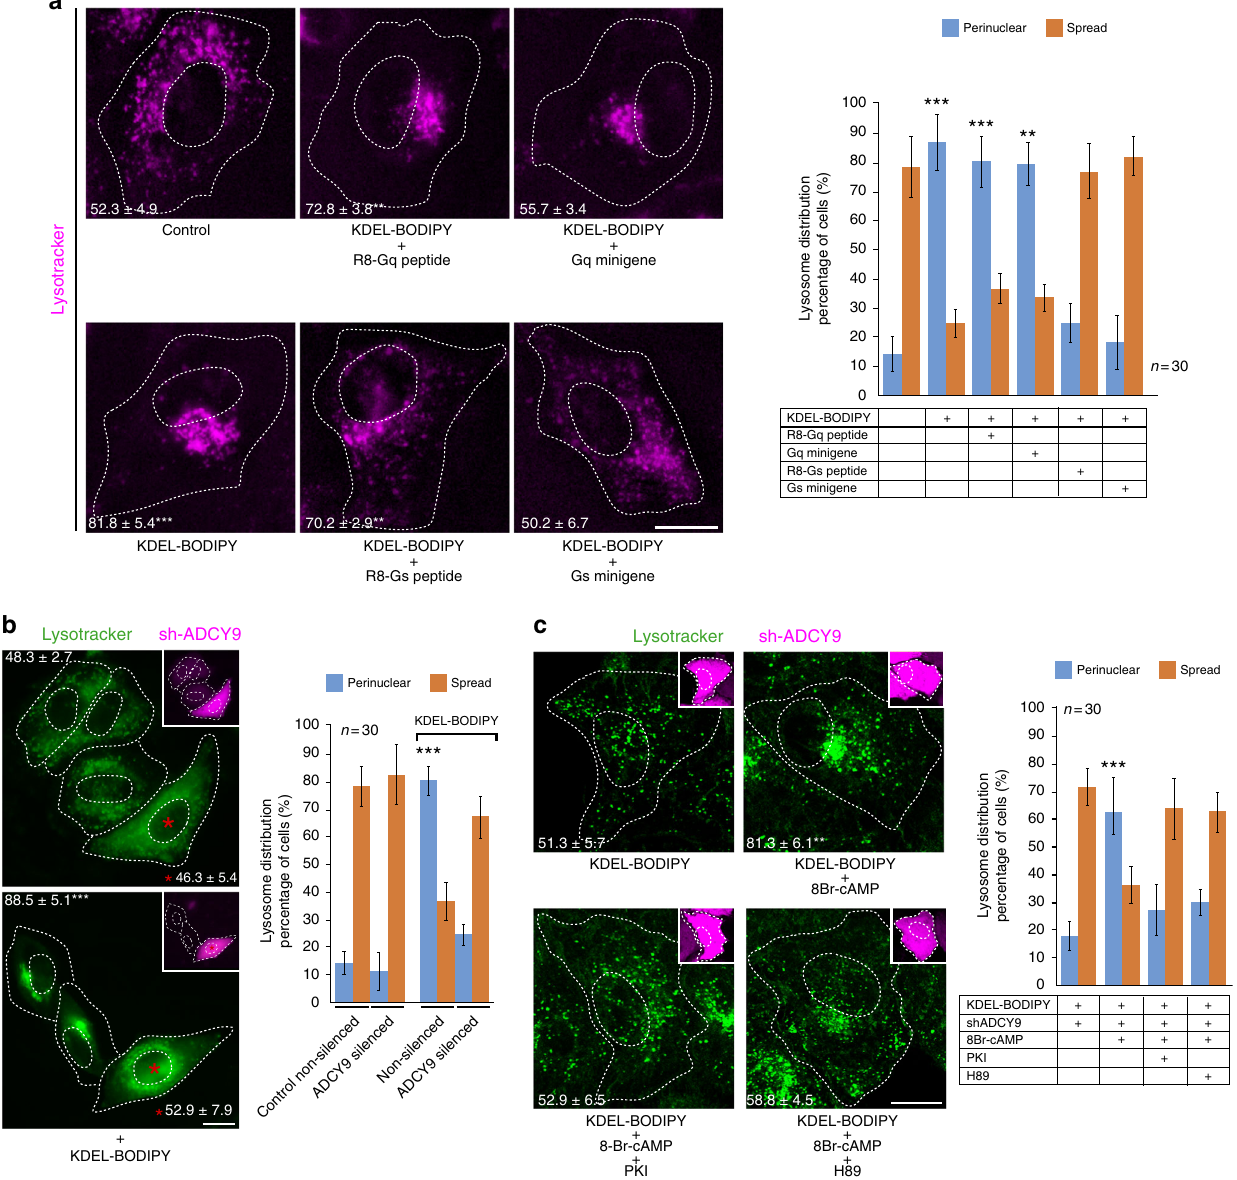
Fig. 3 The KDELR-dependent cAMP/PKA signalling pathway regulates lysosome repositioning. a HeLa cells were left untreated (Control) or incubated for 15 min at 37 °C with 1 µ M KDEL-BODIPY peptide, to activate KDELR, in the absence (KDEL-BODIPY) or presence of either 10 µ M R8-Gq peptide (KDEL-BODIPY + R8-Gq peptide) or 10 µ M R8-Gs peptide (R8-Gs peptide), or in conjunction to transfection for the expression of a Gq minigene (KDEL-BODIPY + Gq minigene) or a Gs minigene (KDEL-BODIPY + Gs minigene). Cells were stained with DeepRed-Lysotracker, and its radial integrated fl uorescence intensity was used to quantify the distribution of lysosomes as described in Methods. The graph shows the percentage of cells depicting cytoplasmically spread or perinuclear lysosome distribution. The perinuclear distribution of lysosomes was quanti fi ed, and the values are indicated at the bottom of each image ( n = 30 cells). b HeLa cells stably transfected with sh-ADCY9 (insets; red fl uorescent protein (RFP)-positive cells; red asterisks) were incubated with Lysotracker green and then either left untreated (Control) or treated with KDEL-BODIPY peptide as in a . Lysosomes distribution was quanti fi ed as indicated in a . The graph shows the percentage of cells depicting cytoplasmically spread or perinuclear lysosome distribution. The perinuclear distribution of lysosomes was quanti fi ed, and the values are indicated at the bottom of each image ( n = 30 cells). c ADCY9-silenced HeLa cells (insets; RFP-positive cells) were incubated with KDEL-BODIPY alone as in a or co-incubated with only the non-hydrolysable cAMP analogue 8-Br-cAMP (100 µ M) or with 8-Br-cAMP in conjunction to either of the PKA inhibitors PKI (50 µ M) or H89 (30 µ M). Lysosome distribution was quanti fi ed as indicated in a . The graph shows the percentage of cells depicting cytoplasmically spread or perinuclear lysosome distribution. The perinuclear distribution of lysosomes was quanti fi ed, and the values are indicated at the bottom of each image ( n = 30 cells). Scale bar, 10 µ m. Data are means± SEM. *** p < 0.001 (Student ’ s t tests). All t tests were conducted comparing to control